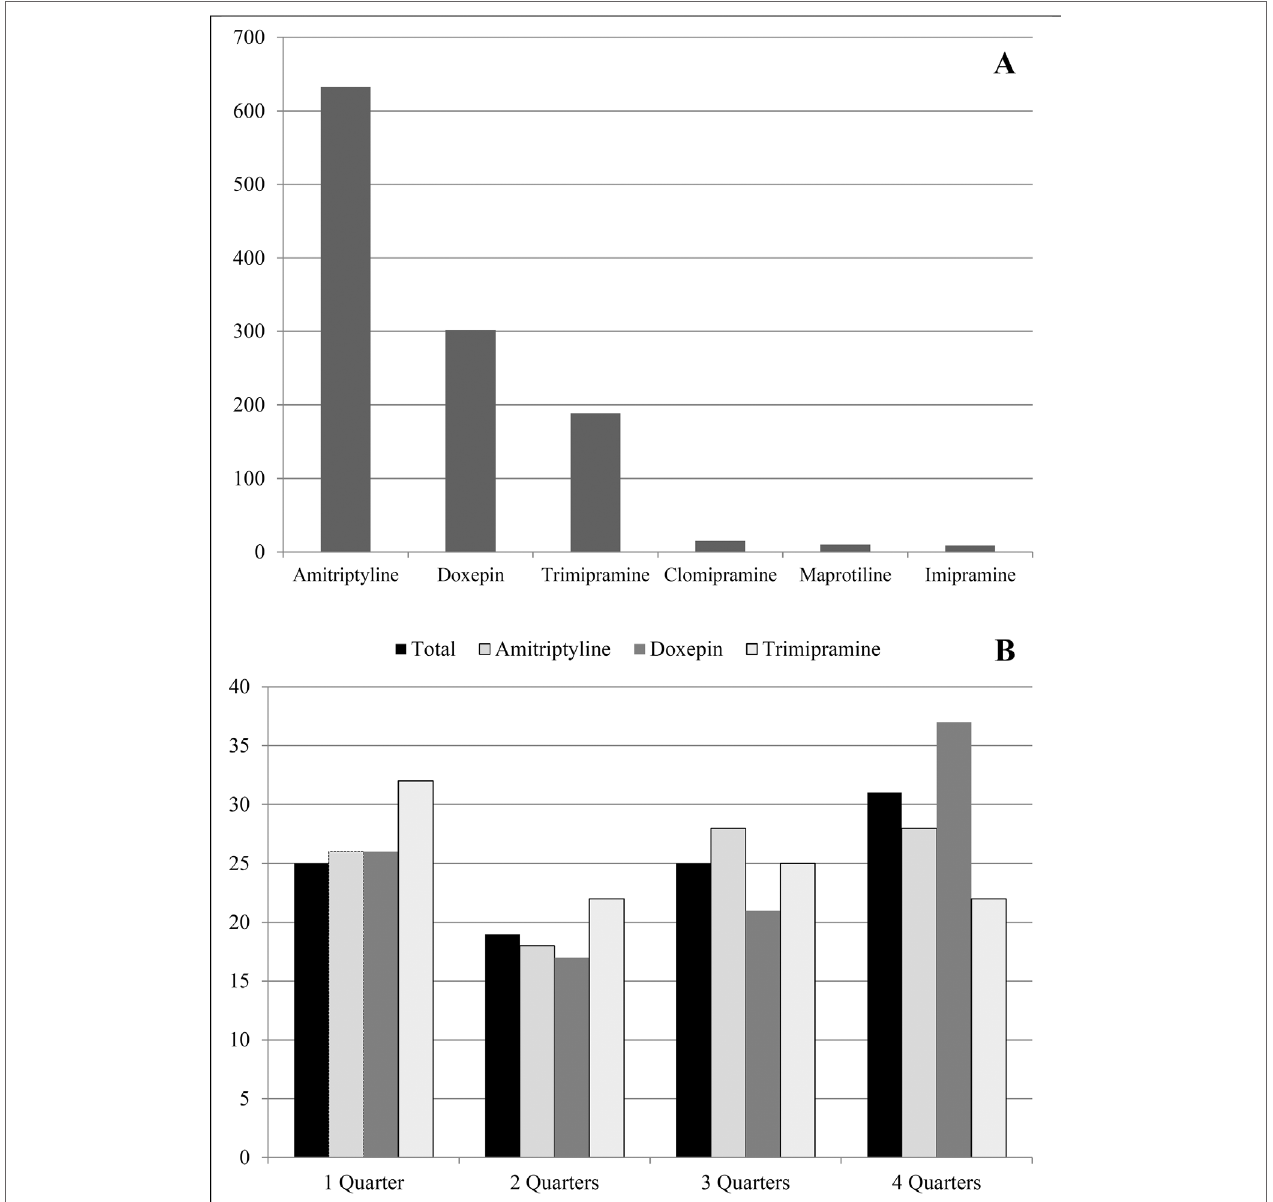
FIGURE 1 | Total number of patients with at least one dispensing of tricyclic antidepressants (TCA) in 2015 (A) and frequency (%) of TCA dispensing in 2015 (B)